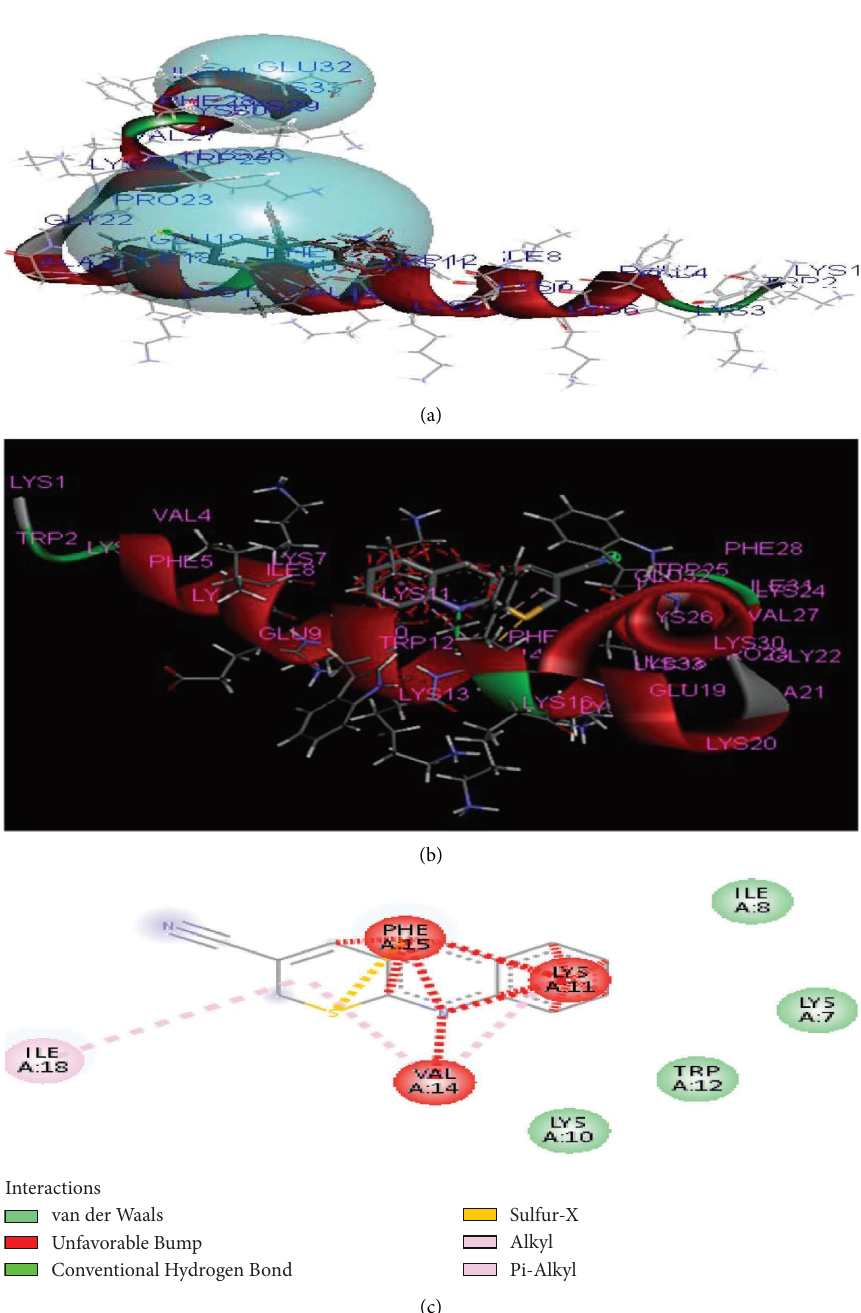
Figure 3: Te binding interaction of thiopyrano[2,3- b ]quinoline ( 1 ) with CB1a (PDB ID: 2IGR) (a) receptor cavities present during interaction, (b) interaction of protein and ligand, and (c)